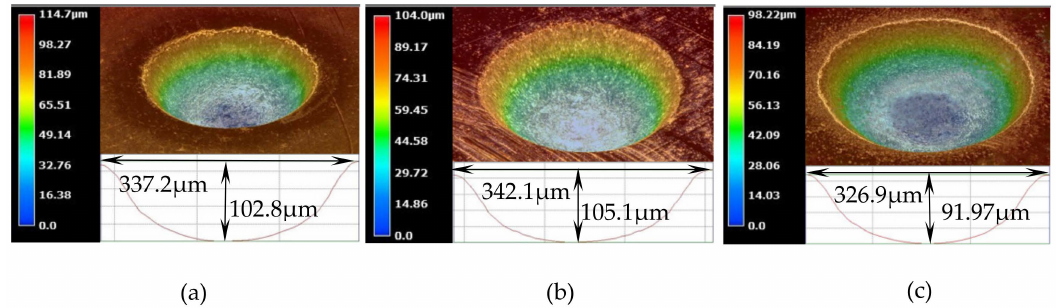
Figure 7. 3D topographies of micro-dimples machined with di ff erent modes produced at 10 V.